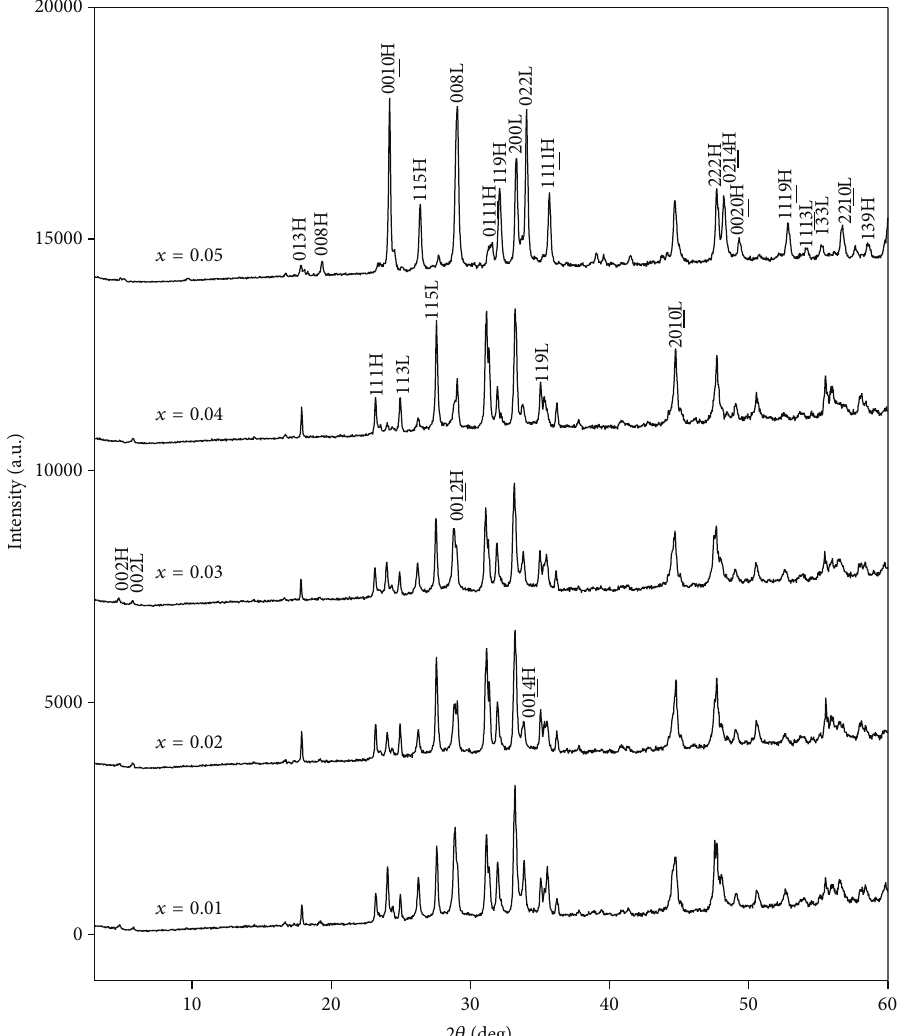
Figure 3: XRD patterns of 30nm Co 3 O 4 added Bi-2223 samples. (H) denotes the high- 𝑇 𝑐 phase (Bi-2223) and (L) denotes the low- 𝑇 𝑐 phase